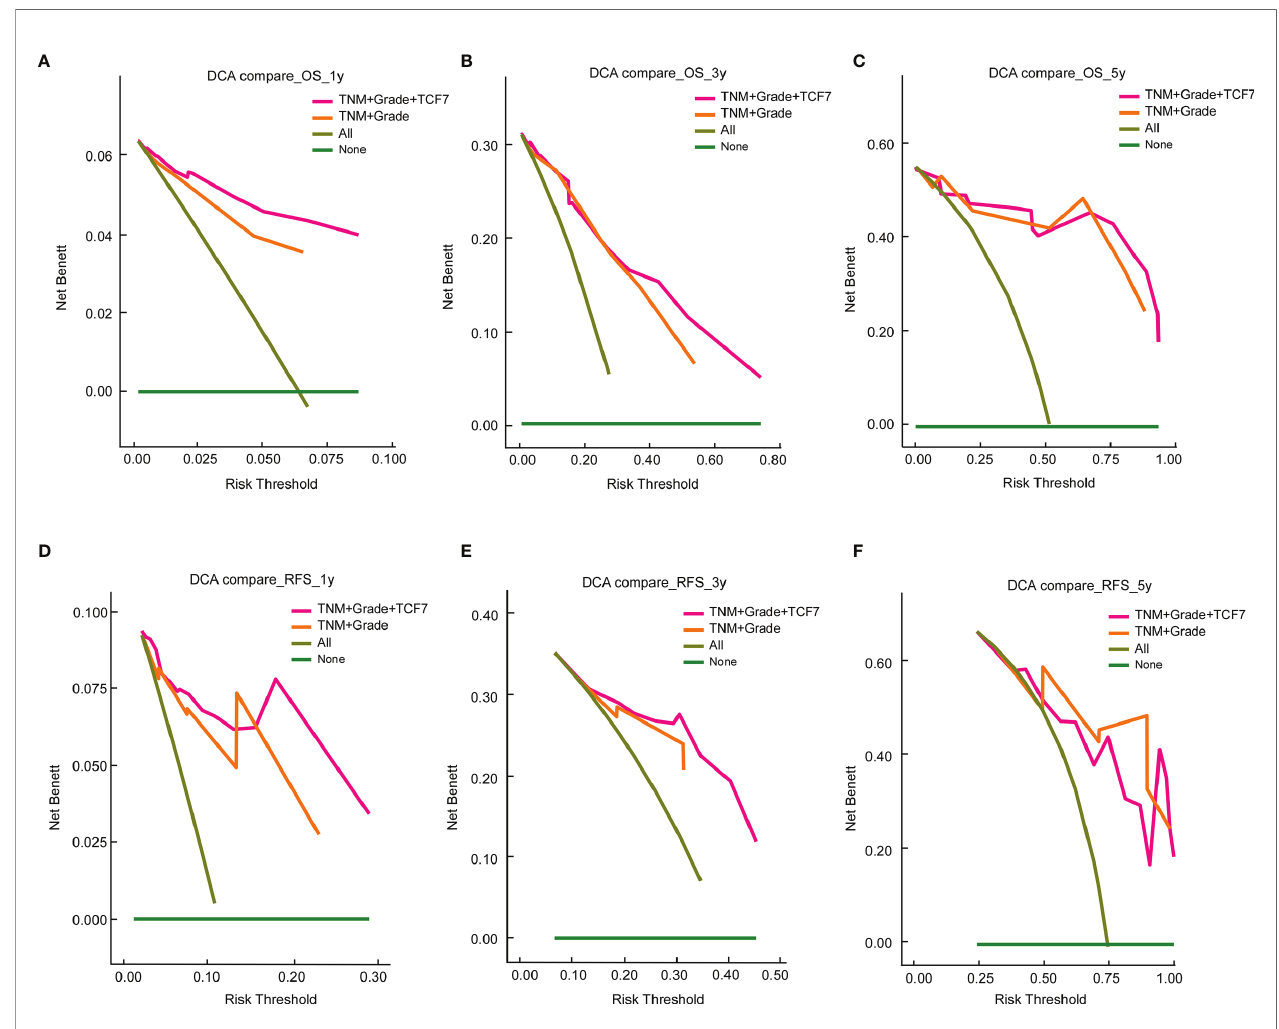
FIGURE 4 | Decision curve analysis comparison of the nomogram and “ TNM+Grade ” models at 1 year (A) , 3 years (B) , and 5 years (C) for OS and 1 year (D) , 3 years (E) , and 5 years (F) for RFS. DCA, decision curve analysis. OS, overall survival; RFS, recurrence-free